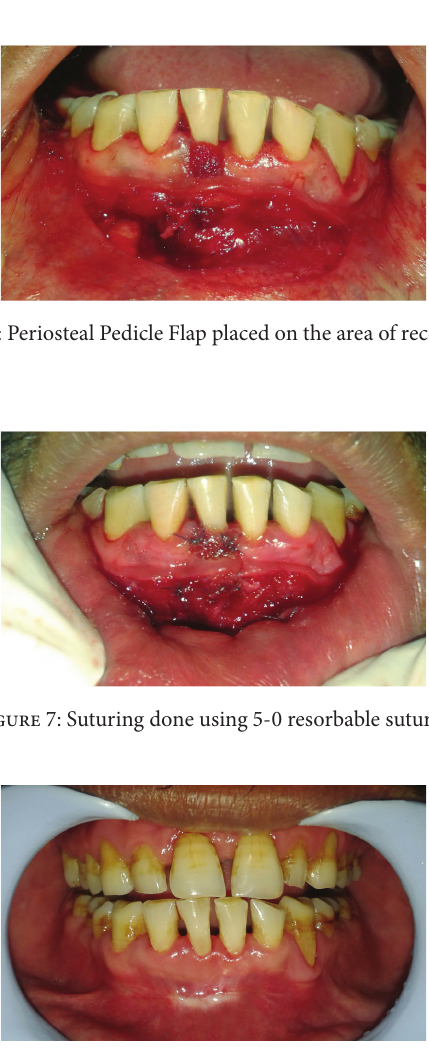
Figure 8: 6-month postoperative